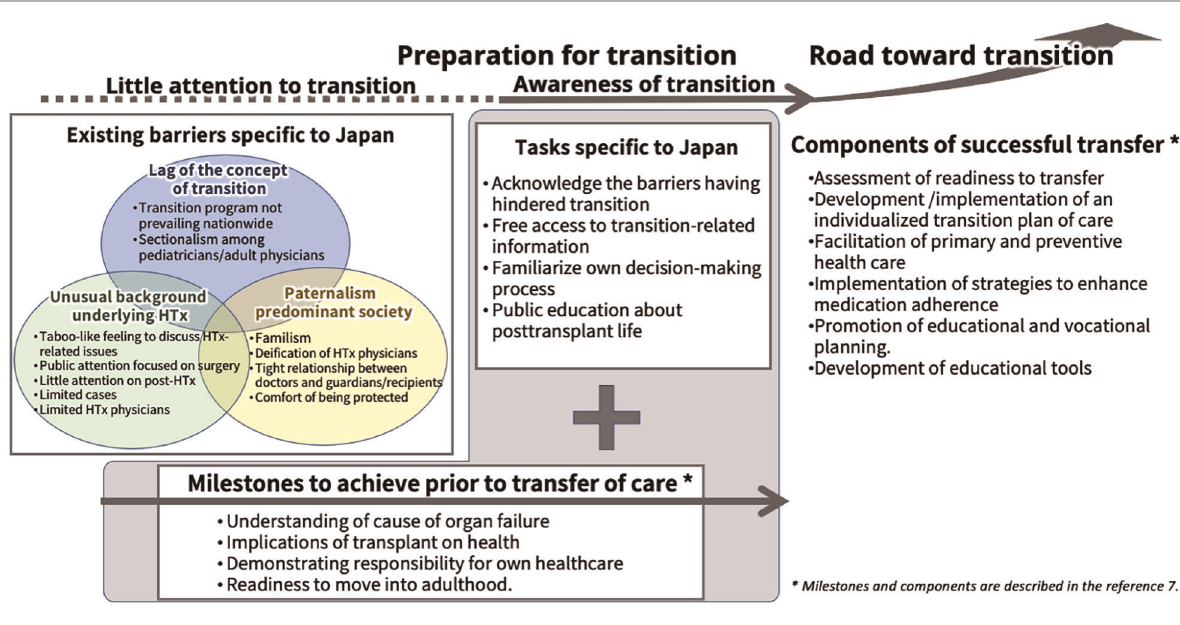
FIGURE 1 The conceptual framework for establishing a transition program for heart transplant recipients in Japan. The transition program has not been fully discussed to date in Japan, and the underlying reasons are described in the three balloons below. The roadmap to a successful transition starts with acknowledging the situation. Critical milestones to achieve and components of successful transfer for young adult patients after solid organ transplantation prior to transfer of care, as described in a consensus conference report (7), are shown in the fi